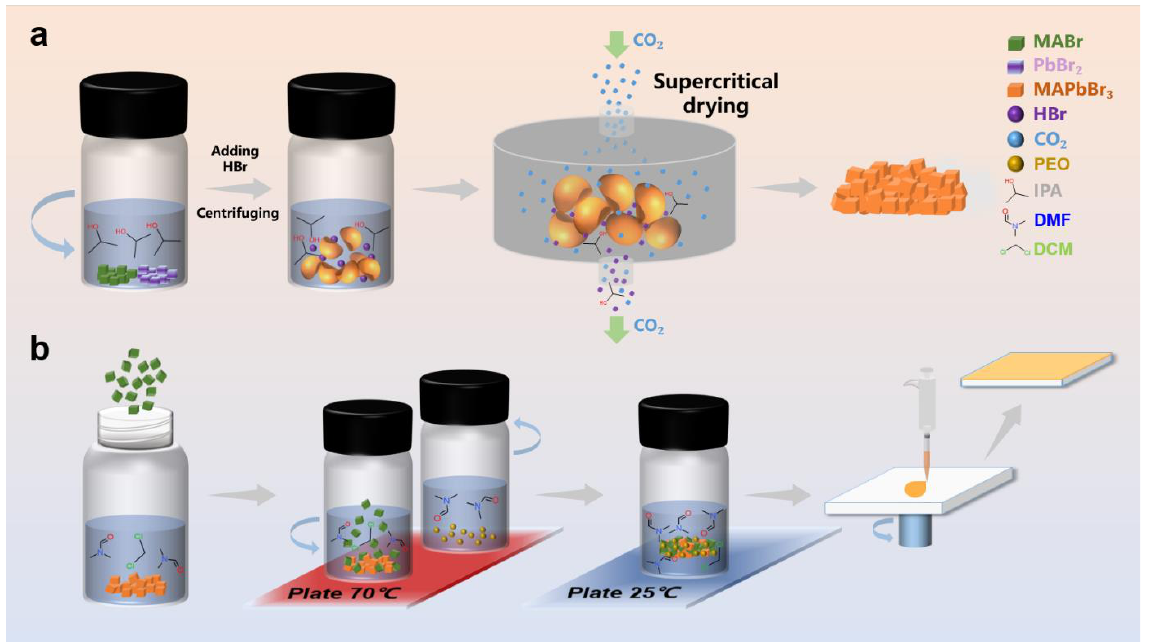
Figure 1. Preparation of MAPbBr 3 , PBC, and PPC. ( a ) Schematic illustration of the preparation of hybrid perovskite by supercritical drying. ( b ) Schematic illustration of the facile synthesis of halide-rich hybrid perovskite nanocomposite films. The blend solution was made from MAPbBr 3 , MABr, and PEO powder, then directly spin-coated into a bromine-rich nanocomposite film.